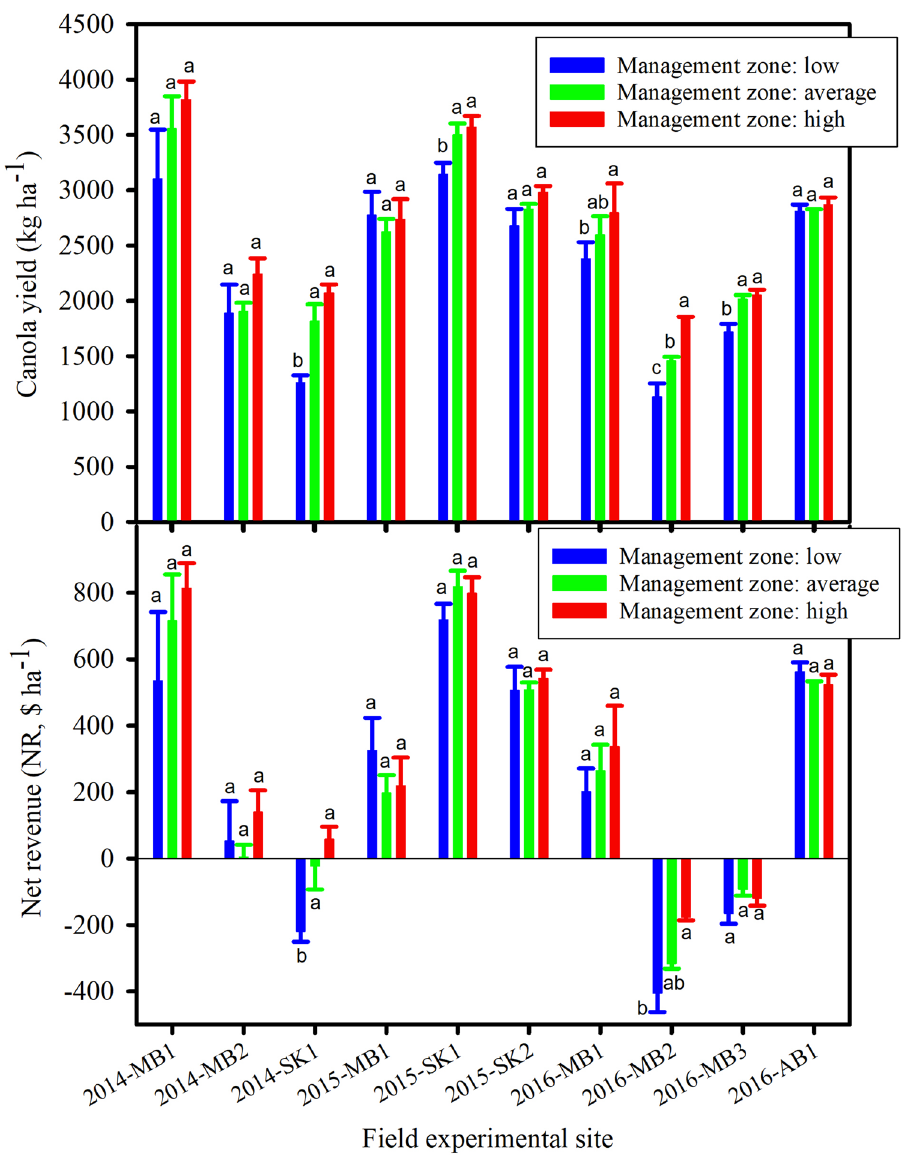
Figure 4. Canola yield and net revenue at 50–100% recommended nitrogen fertilizer treatments in three canola management zones for ten field experimental sites from 2014 to 2016. The same letters on the top of bars for each site are not significant among management zones ( p > 0.05) (SigmaPlot, vision 14, https ://systa tsoft ware.